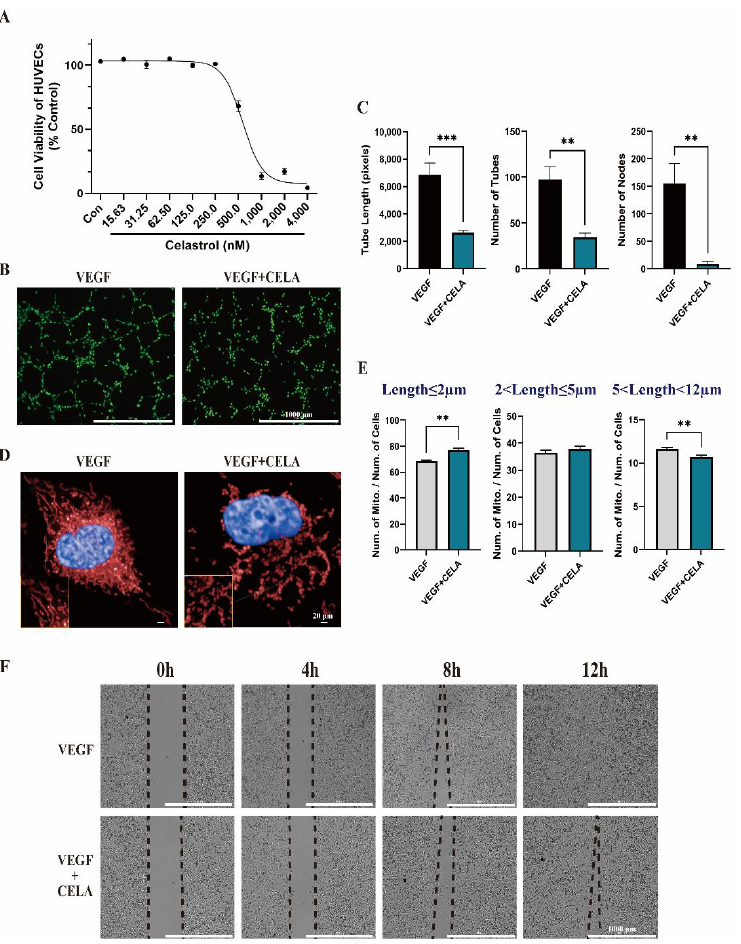
Figure 2. Celastrol showed an inhibitory effect on tumor angiogenesis in HUVECs. ( A ) Cell viability of HUVECs after 24 h celastrol treatment. ( B ) The effects of celastrol on Matrigel tube formation. ( C ) The effects of celastrol on the nodes of tubes, the number of tubes, and tube length. ( D , E ) The effects of celastrol on mitochondrial length evaluated by high-content screening. ( F ) The wound- healing migration assay showed the effects of celastrol on the migration capacity of HUVECs. ** p < 0.01, *** p <